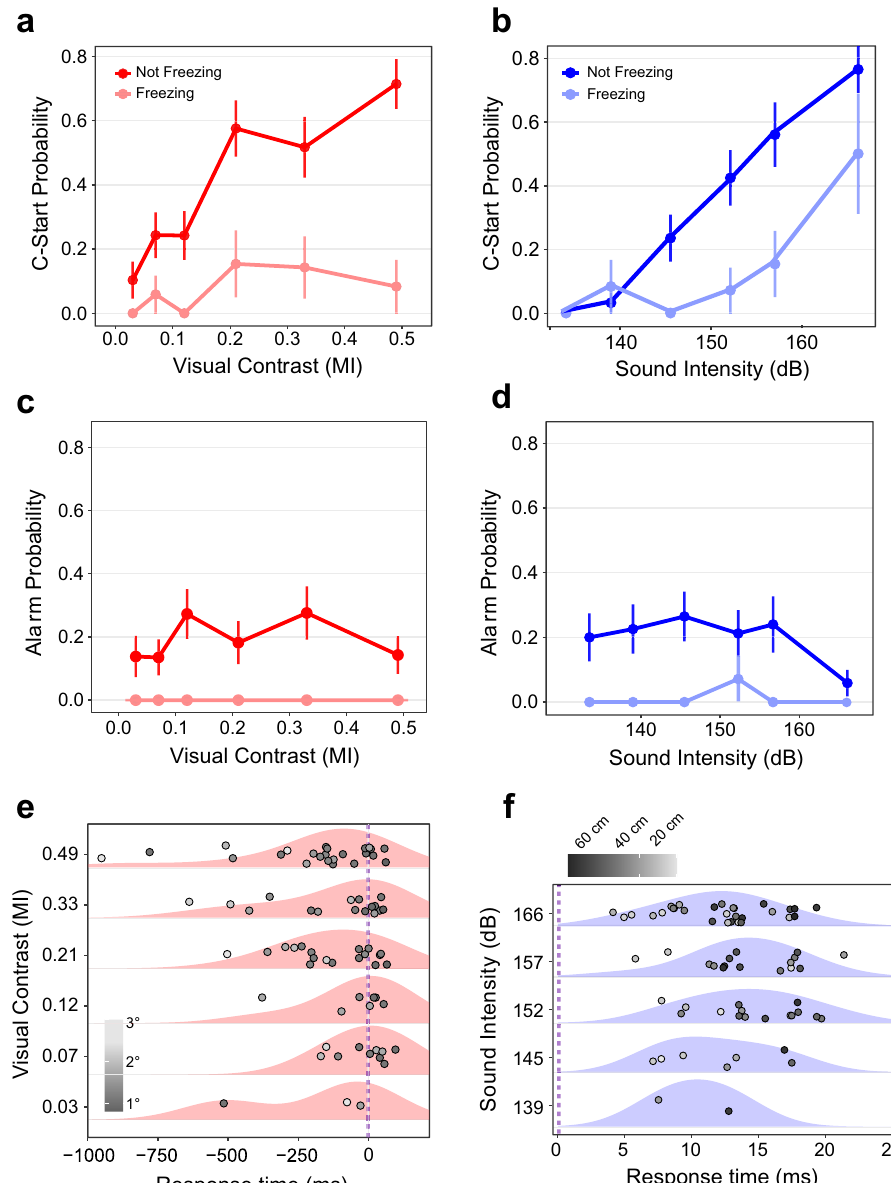
Figure 3. Unisensory stimulus intensity modulates C-start response in non-freezing animals. Unisensory C-start probability as a function of visual contrast ( a , N = 118) or auditory intensity ( b , N = 108) for non- freezing and freezing fish. Number of trials for each intensity vary between n = 29–37 for non-freezing and n = 12–19 for freezing trials. Alarm probability as a function of intensity for visual ( c , N = 118) or auditory ( d , N = 108) unisensory stimuli for non-freezing and freezing fish. Number of trials for each intensity varies between n = 25–34 for non-freezing and between n = 8–14 for freezing trials. In ( a – d) bars represent standard error for the proportion. ( e ) Individual response times and density distributions for C-starts grouped by visual contrast (n = 83, N = 53). Dots are shaded according to the looming’s subtended angle (°) from the perspective of the animal, measured 1250 ms before the end of expansion. Temporal scale is zeroed at the end of the loom expansion (dashed line). ( f ) Individual response times and density distributions for C-starts grouped by sound intensity (n = 70, N = 47). The lowest intensity yielded no responses. Dots are shaded according to the animal’s distance to the speaker (cm), 1 s before stimulus onset. Temporal scale is zeroed at the onset of auditory stimulation (dashed line). Shaded red or blue areas show density distributions of response times computed using a gaussian kernel. Vertical scatter was added for clarity in ( e ) and ( f)